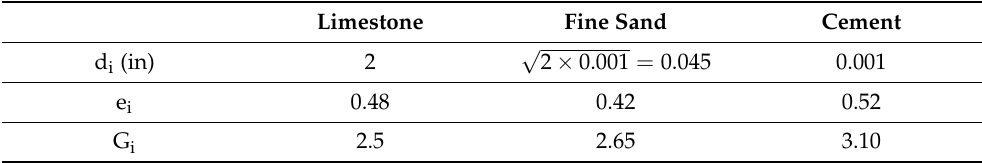
Table 2. Example Data for Calculation of Packing